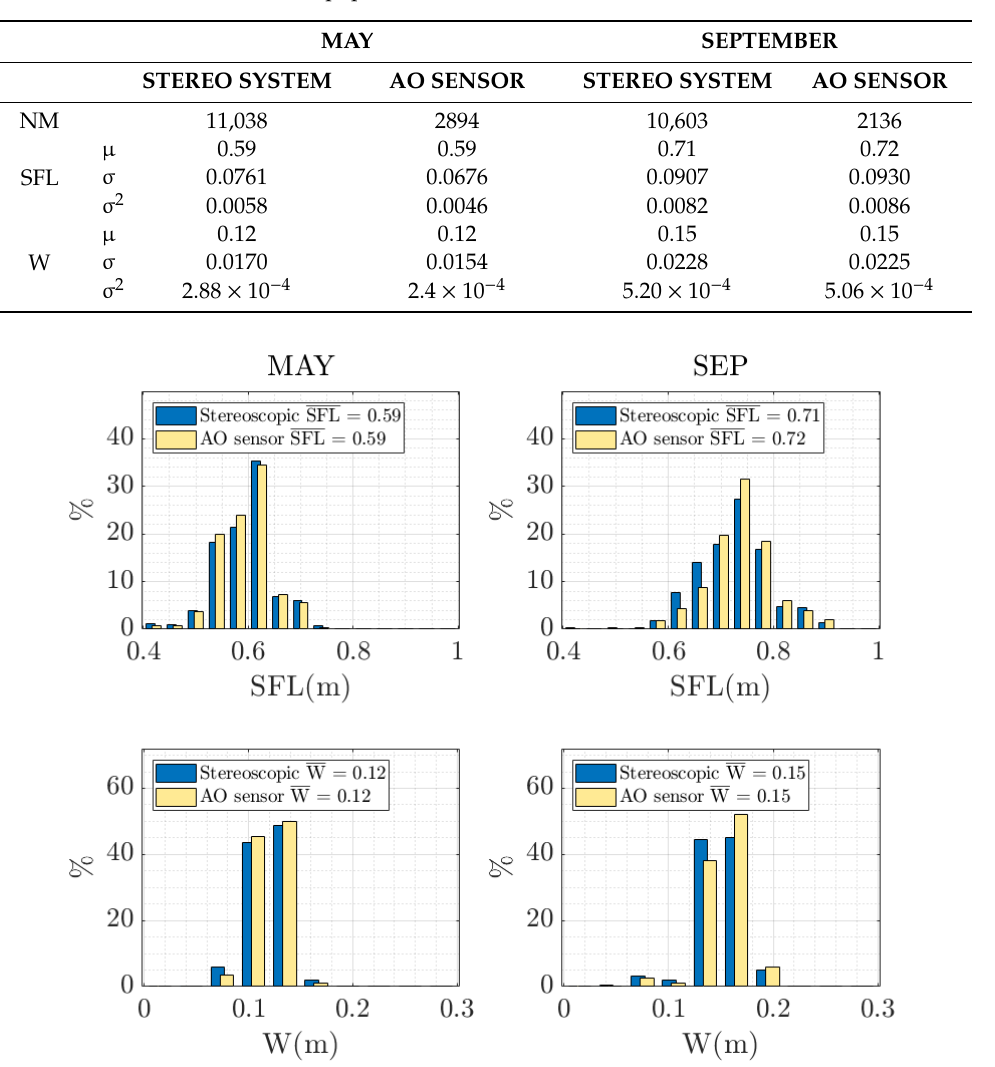
Figure 11. Snout fork length (SFL) and width (W) frequency histograms with the measurements from the acoustic–optical (AO) sensor and the stereoscopic system.